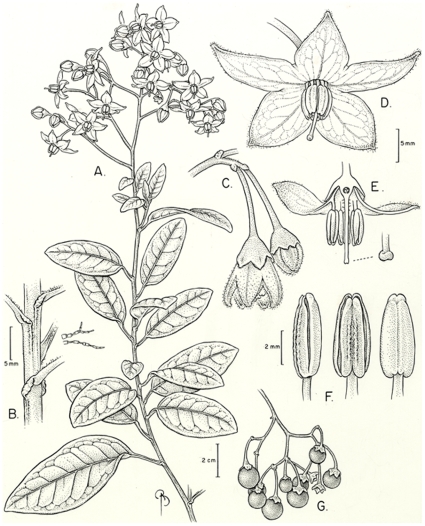

Solanum sanchez-vegae.A) portion of stem, B) petiole articulation, C) buds, D) open flower, E) flower cross-section showing stigma detail, F) anthers, G) fruit. A–F drawn from Smith & Sanchez-Vega 7524, G from Hutchison et al. 5738.